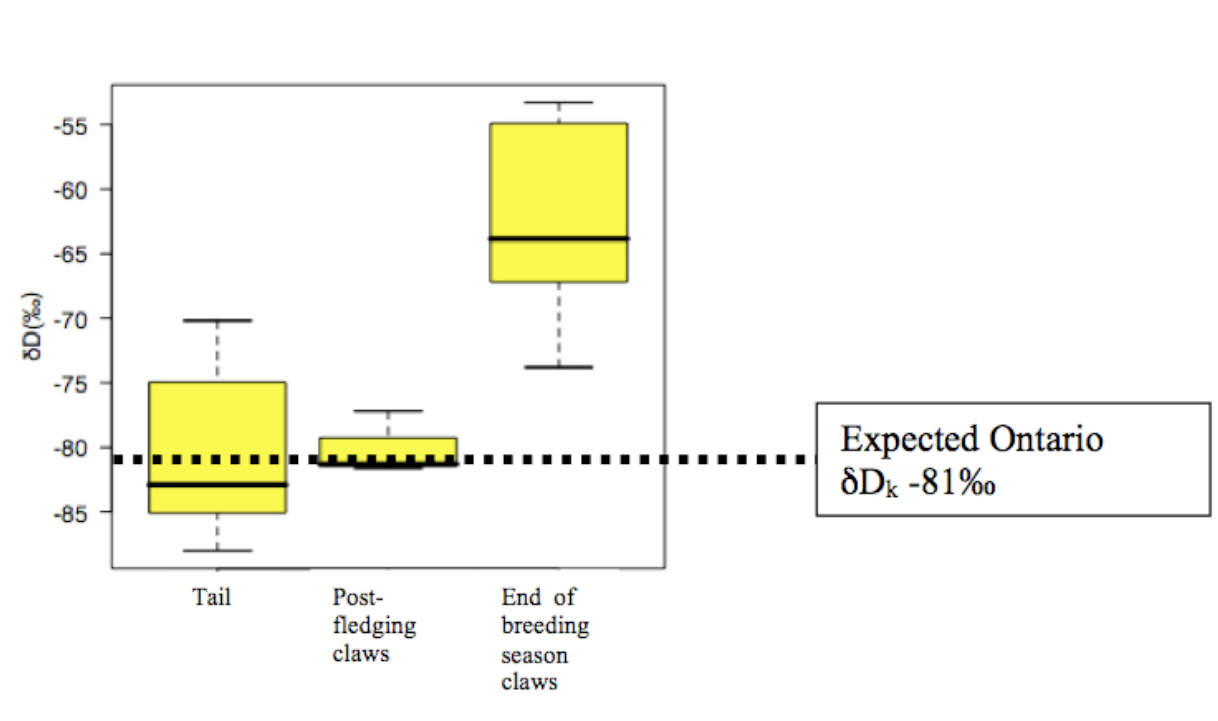
Fig. 3. d D values of breeding Golden-winged Warbler adult tail retrices ( n = 8) and recent fledgling k claws ( n = 3) compared with d D values of claws ( n = 10) collected near the end of the breeding season k (1–10 July 2005). Tail feathers and claws grown in Ontario reflect locally expected values. Claws collected at the end of the breeding season in Ontario do not yet reflect local